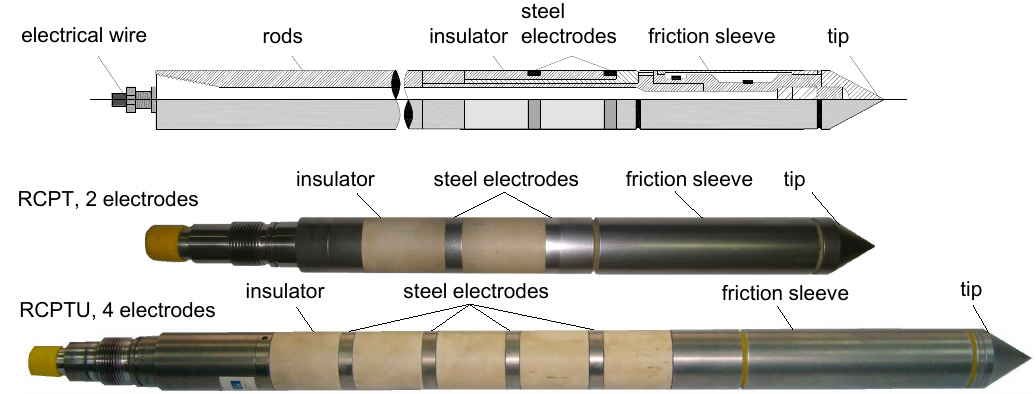
Figure 4. Cross-section and photographs of RCPT and RCPTU cones.